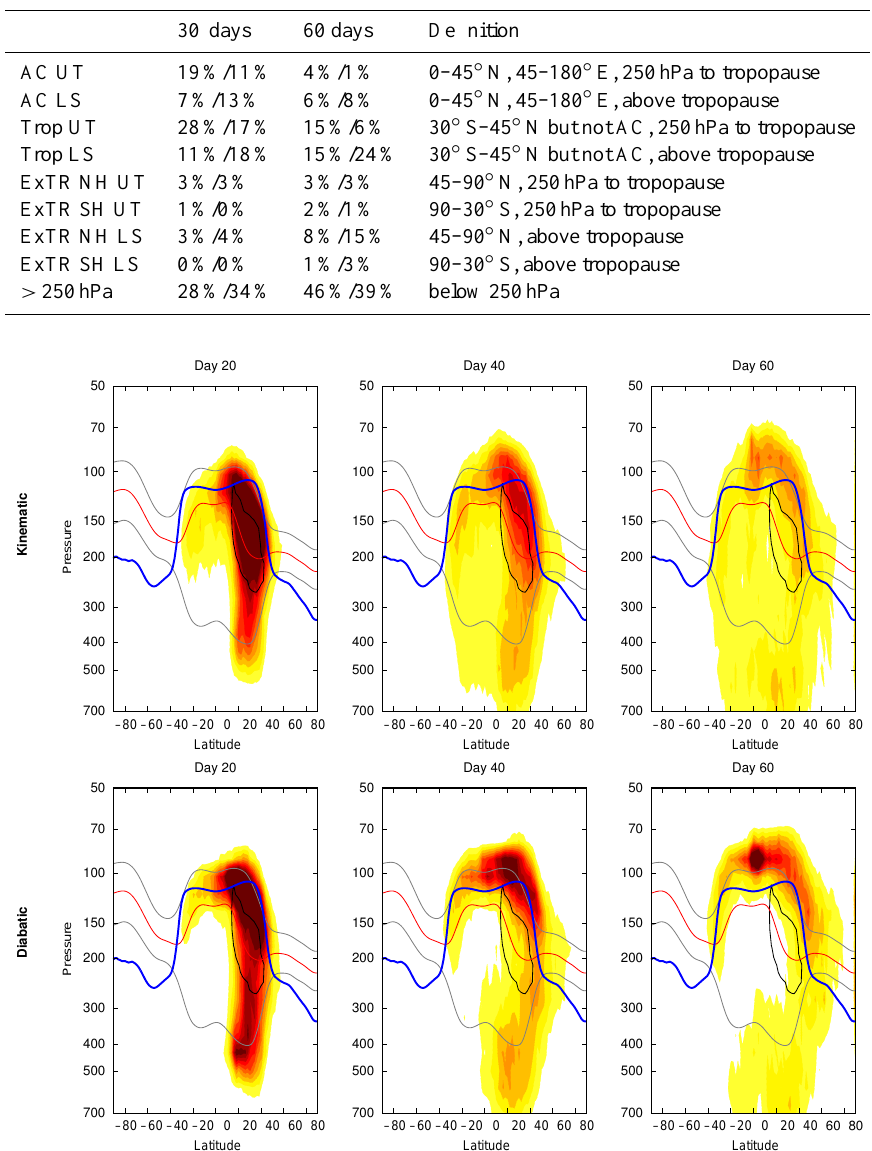
Figure 6. Mean distribution of three-dimensional kinematic trajectories (top panels) and three-dimensional diabatic trajectories (bottom panels) released within the anticyclone at 360K on day 20, 40 and 60 after their release given as fraction of total number of trajectories (dark (5 × 10 − 3 ) to light yellow (5 × 10 − 4 )). The black contour indicates the initial distribution of trajectories, and the dark blue line is the mean thermal tropopause between 20–120 ◦ E. The red line is the mean location of the 360K level in 45–120 ◦ E, and the gray lines are the 340 and 380K